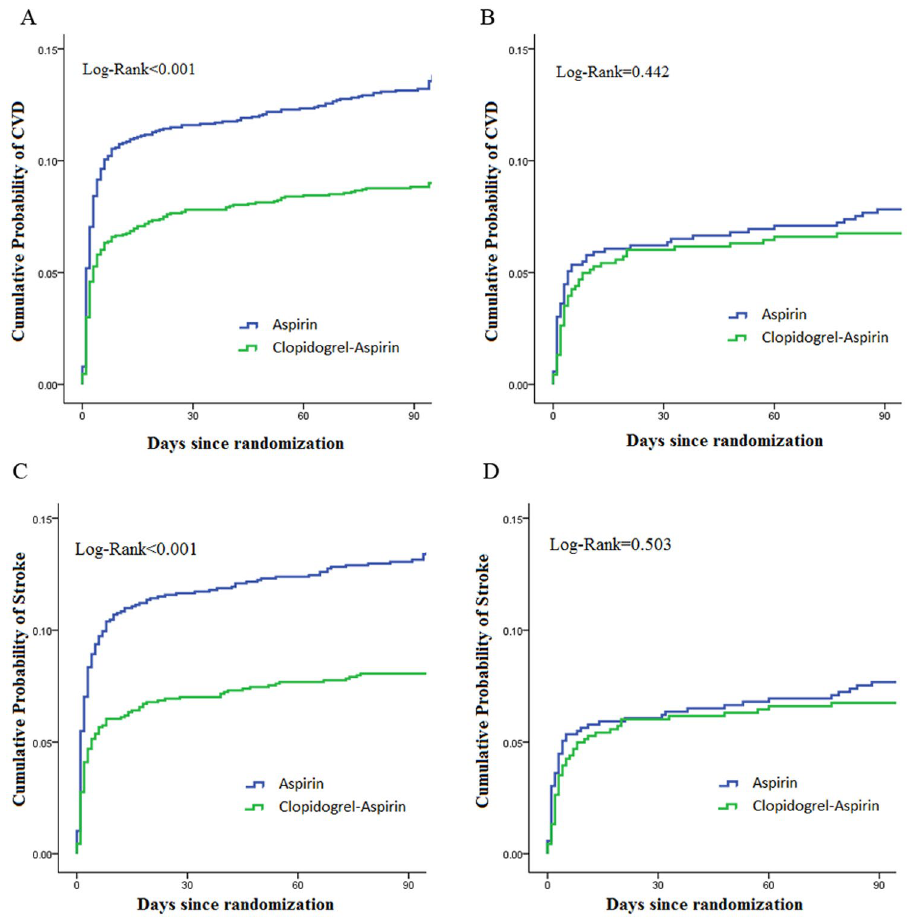
Figure 1. Kaplan-Meier curves showing the time to stroke outcomes in patients with SBP ≥ 140 mmHg or SBP < 140 mmHg, treated with clopidogrel-aspirin or aspirin alone. ( A ) Cumulative probability of CVD by treatment among patients with SBP ≥ 140 mmHg; ( B ) Cumulative probability of CVD by treatment among patients with SBP < 140 mmHg; ( C ) Cumulative probability of stroke by treatment among patients with SBP ≥ 140 mmHg; ( D ) Cumulative probability of stroke by treatment among patients with SBP < 140 mmHg. Abbreviations: CVD = combined vascular events (ischemic stroke, hemorrhagic stroke, myocardial infarction, or vascular death); SBP = systolic blood